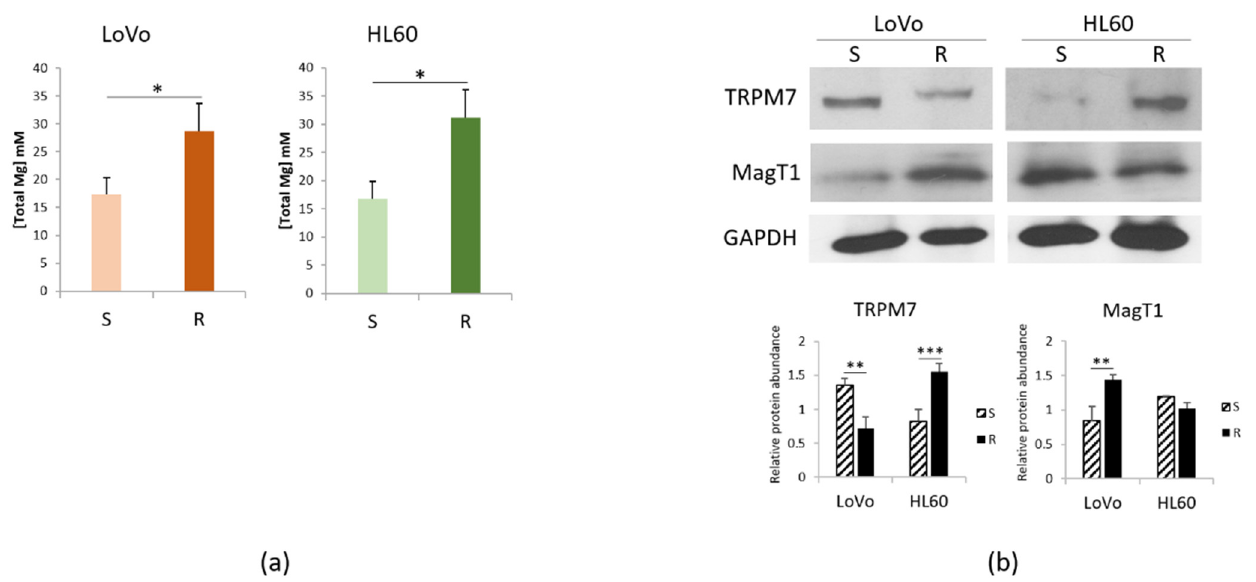
Figure 3. Mg homeostasis in DXR sensitive and resistant cells. LoVo and HL60 were cultured for 48 h in their culture medium. ( a ) Total intracellular Mg was measured. ( b ) Western blots were performed on protein lysates using antibodies against TRPM7 and MagT1. GAPDH was used as control of loading. A representative blot and densitometry obtained by ImageJ are shown. * p < 0.05; ** p < 0.01; *** p < 0.001.